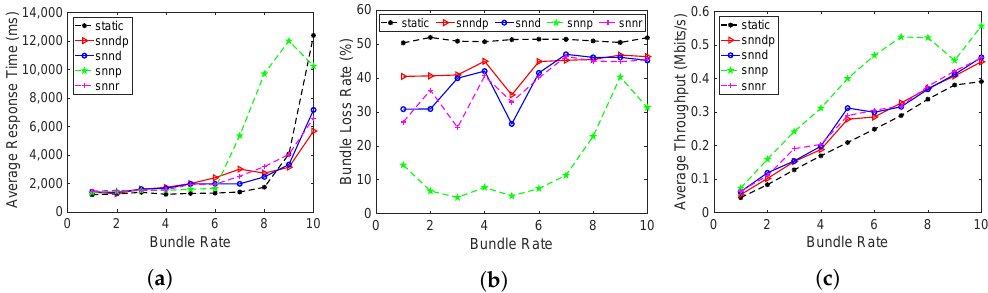
Figure 7. Routing performance: Scenario 3. ( a ) Average response time; ( b ) Packet loss ratio (%); ( c )